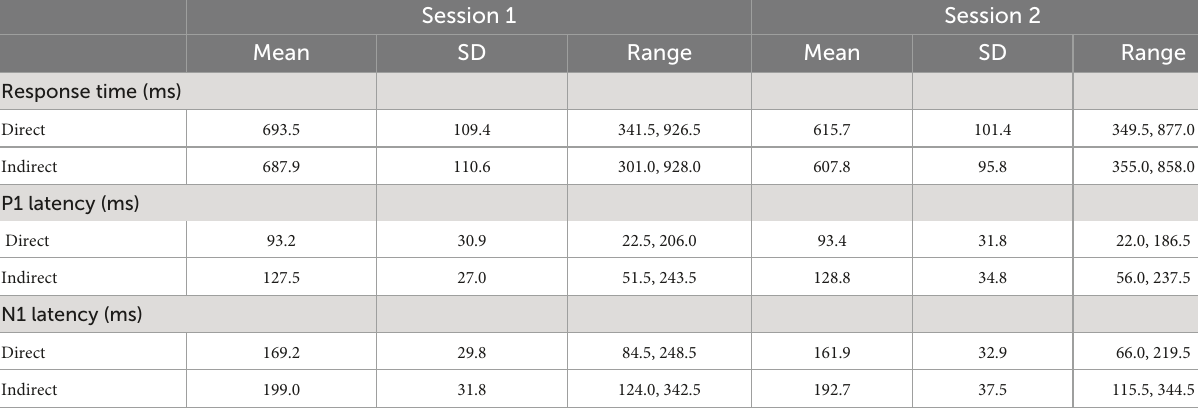
TABLE 3 Manipulation checks.